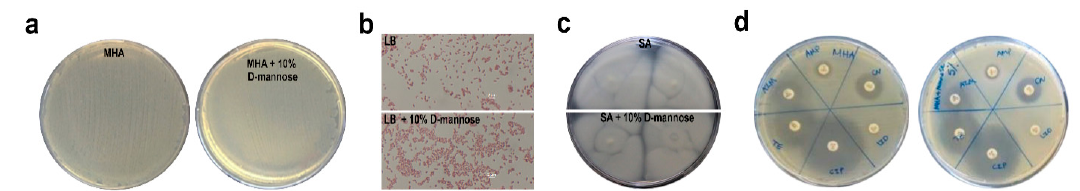
Figure 1. Impact of d -mannose on bacterial properties and antimicrobial activity. ( a ) Strain CFT073 was seeded on Mueller Hinton agar (MHA) plates supplemented with and without 10% d -mannose. ( b , c ) Otherwise, strain CFT073 grown overnight in Luria Bertani (LB) broth with and without 10% d -mannose was Gram stained or spotted onto soft agar (SA) plates, respectively. ( d ) The antibiotic susceptibility of strain CFT073 was assessed in the presence or absence of 5% d -mannose by the Kirby–Bauer disk di ff usion susceptibility test on MHA plates; CN: Gentamicin; AMP: Ampicillin; AZM: Azithromycin; LZD: Linezolid; TE: Tetracycline; CIP: Ciprofloxacin. Representative images of two independent experiments.